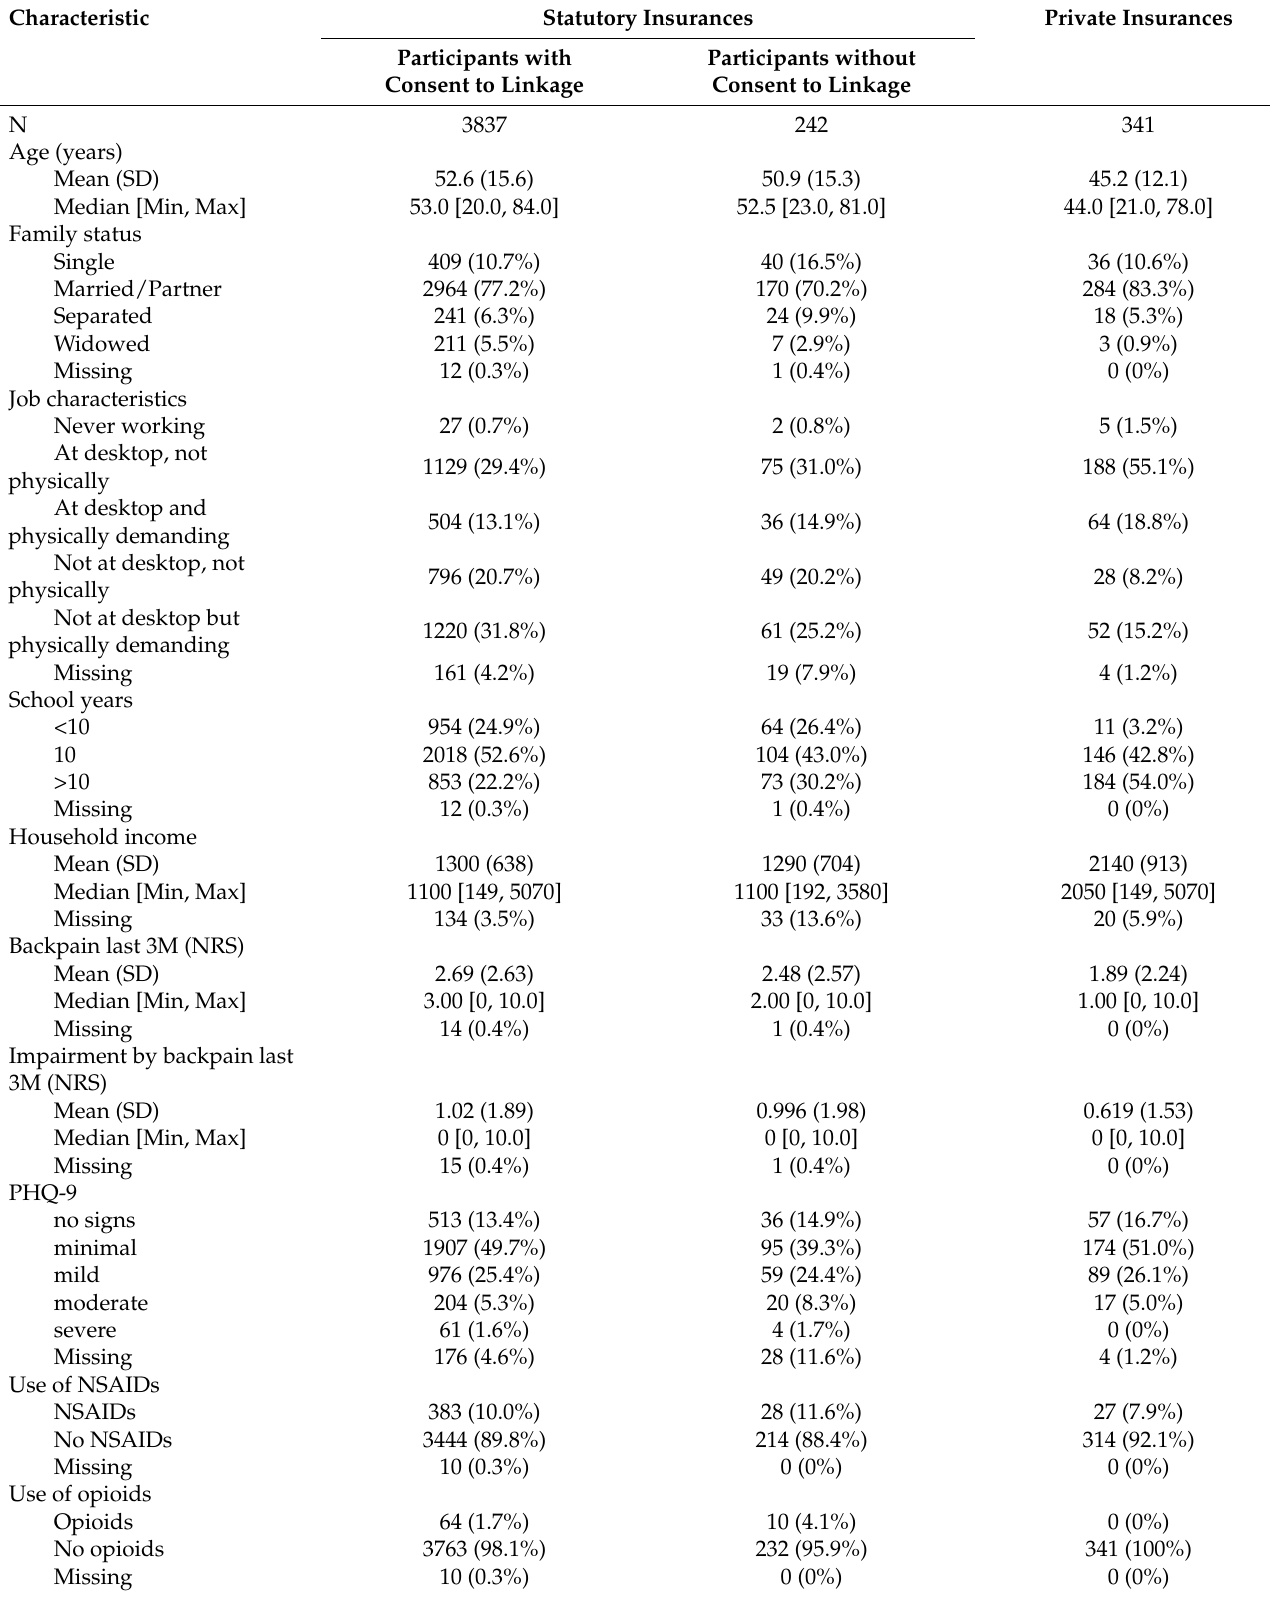
Table 1. Characteristics of participants of the Study of Health in Pomerania TREND-0